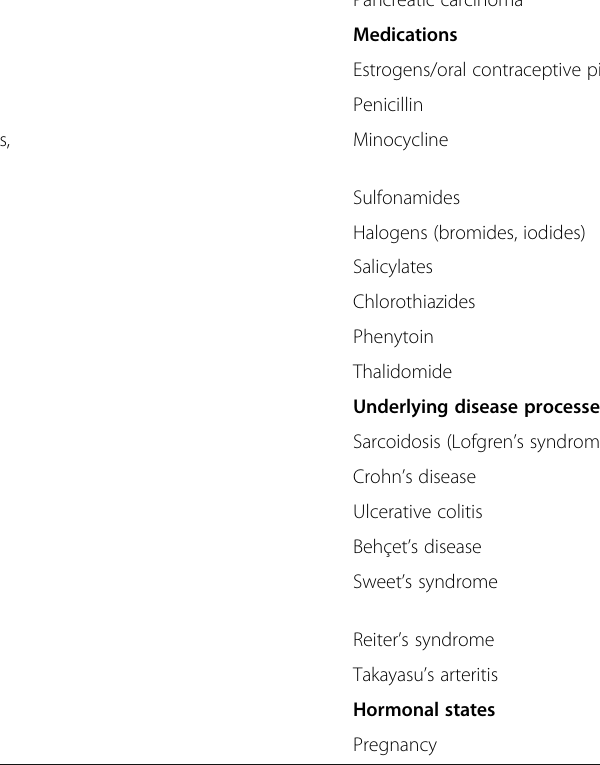
Table 1 Etiologic factors in erythema nodosum